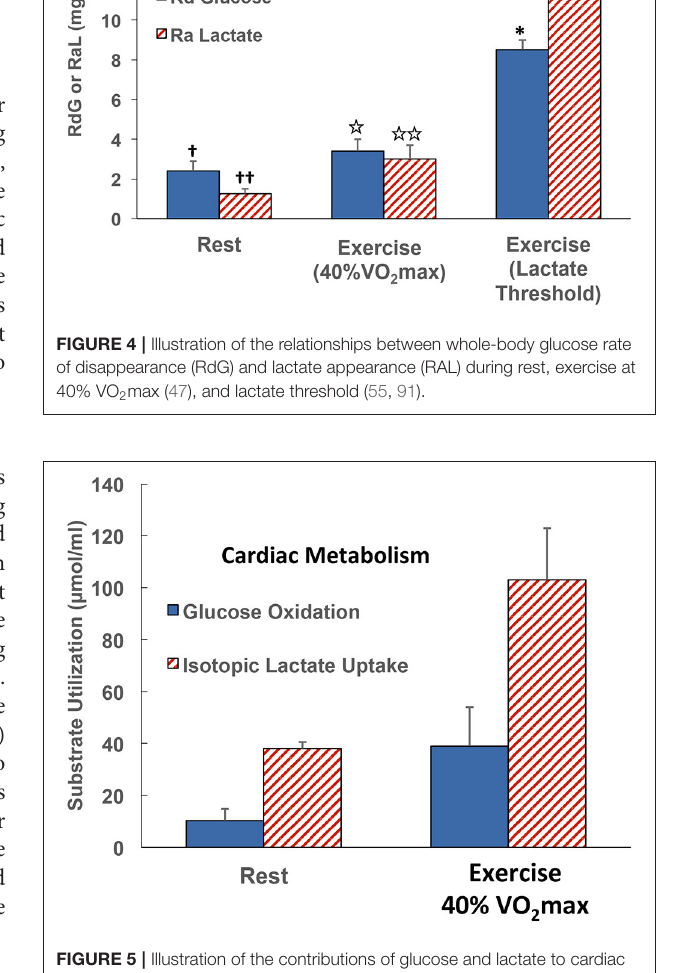
FIGURE 5 | Illustration of the contributions of glucose and lactate to cardiac metabolism in healthy men studied at rest and during supine leg cycle ergometry at 40% VO 2 max (see Figure 1 ) (29). Results are to be compared with those in the same subjects resting and exercising at 40% of VO 2 max (see Figure 4 ). Results are also to be compared with those on one subject, the author, but in Figure 2 the role of fatty acids in supplying energy for cardiac metabolism is depicted. Results show that the contribution of lactate to cardiac energy need depends on arterial lactate concentration and is significantly greater than that of glucose. Results in Figure 2 also show crossover from fatty acid to lactate dependence in heart during exercise. Data from